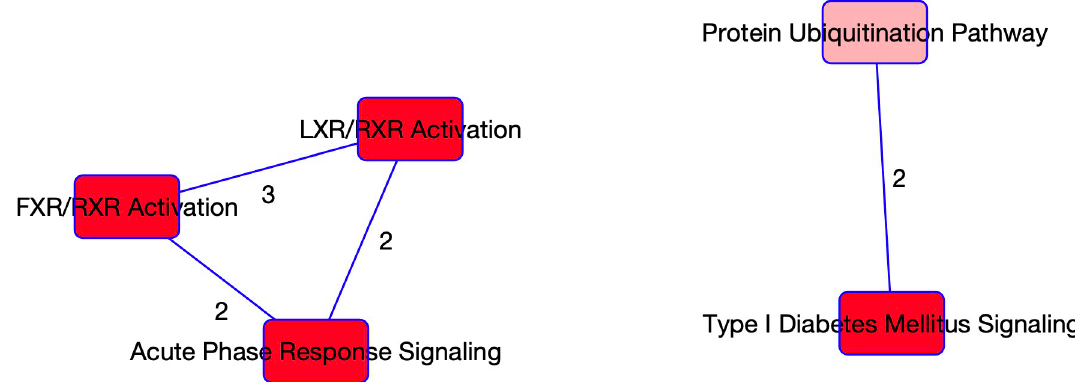
Fig 4. Overlapping networks associated with COVID-19. Visual of the overlapping networks enriched in COVID-19 as determined from the proteomics data. The nodes represent the networks, and the edges represent the overlapping proteins between the networks. The edge labels give the number of overlapping molecules between the